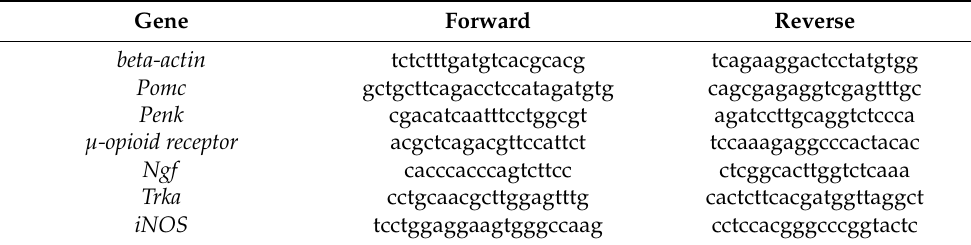
Table 1. Sequences of the RT-PCR